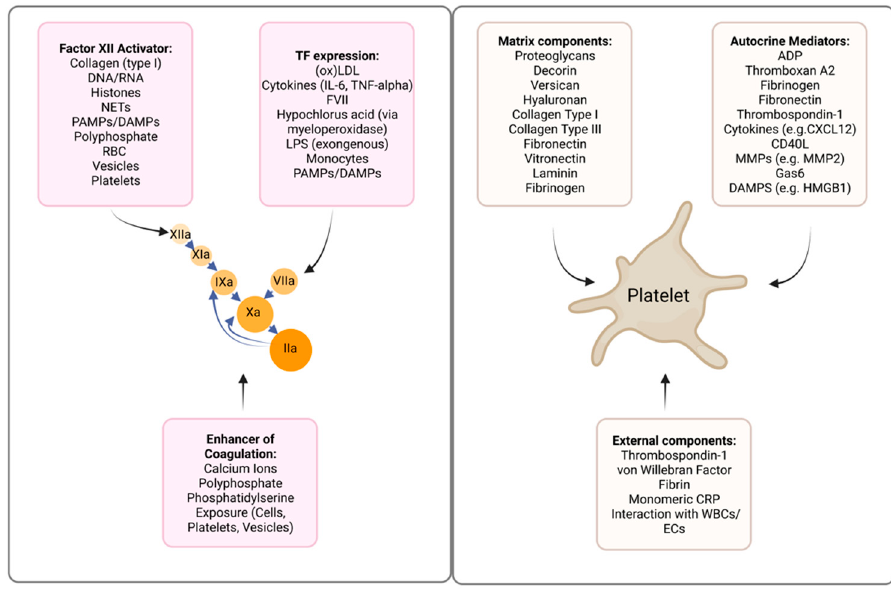
Figure 2. Atherosclerotic plaque-associated activators and mediators of coagulation and platelets. Created with Biorender.com (accessed on 10 October